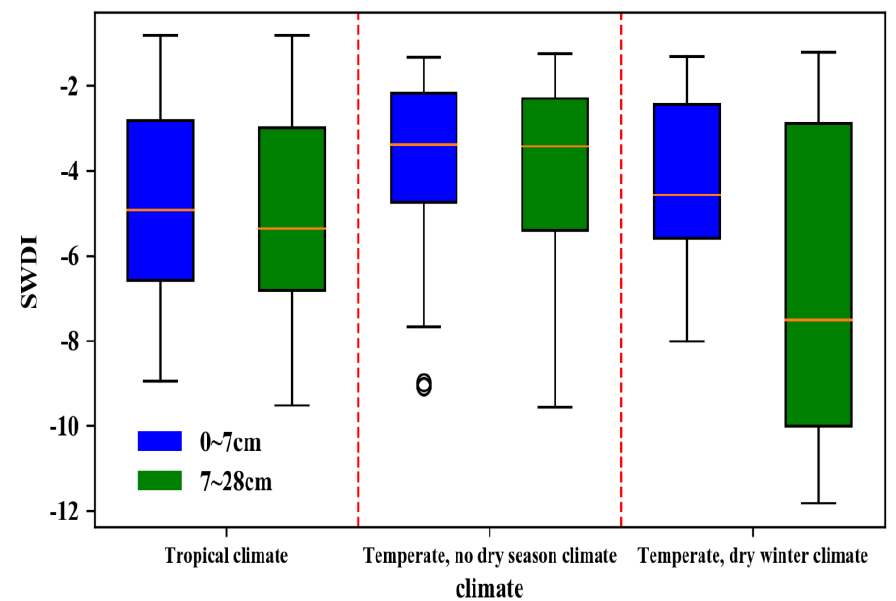
Figure 5. The distribution of the weekly SWDI in the surface and subsurface during 2017–2019.